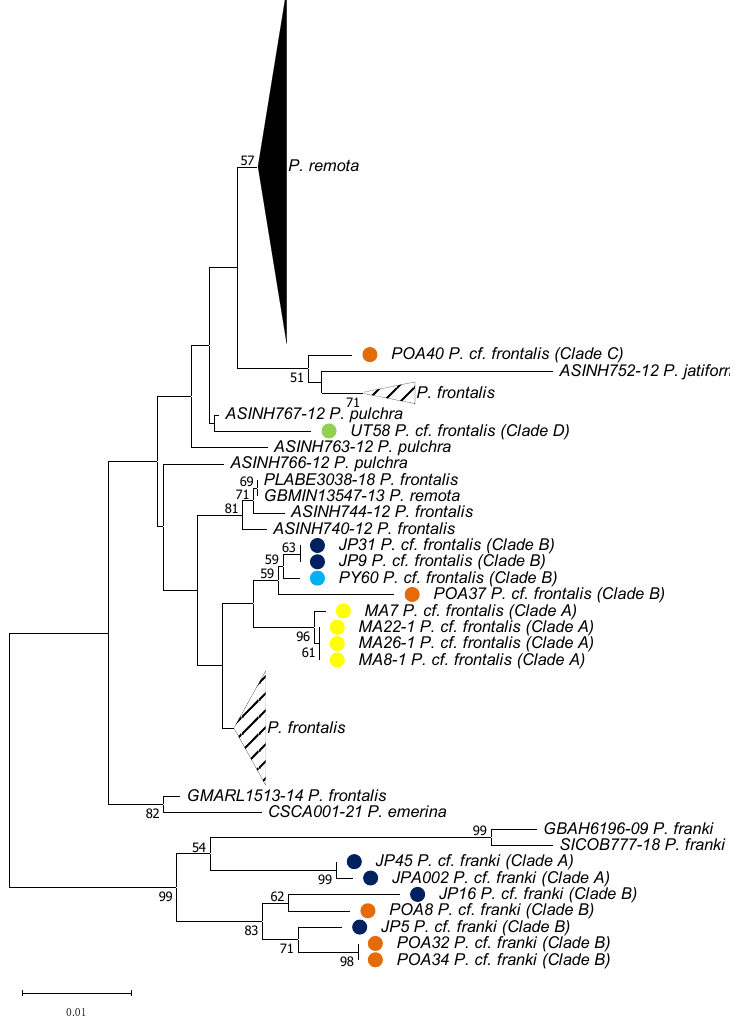
Figure 4. Neighbour-joining COI tree (K2P corrected distances) of Plebeia . Only bootstrap values > 70 are shown. Original sequence data were merged with those retrieved in BOLD. Labels of Peruvian specimens collected in this study are highlighted in different colors, according to sampling sites.